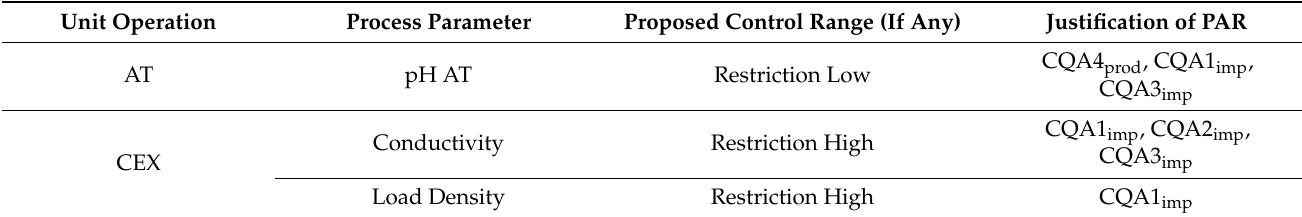
Table 3. Summary overview of automated results for PAR setting by